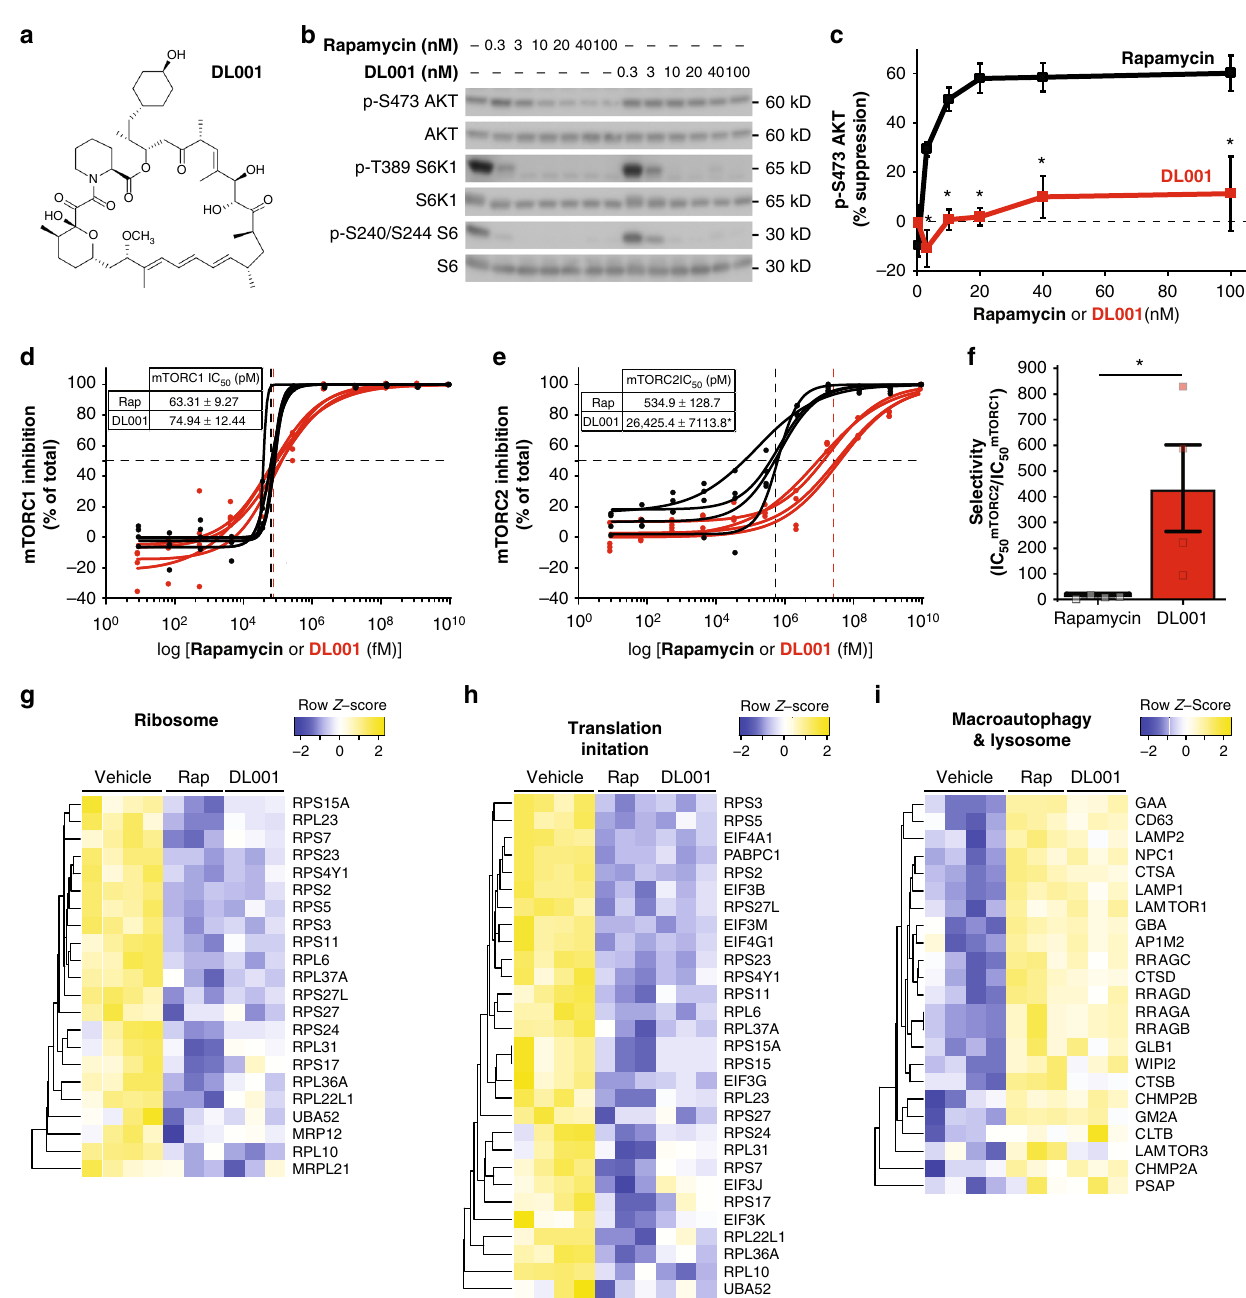
Fig. 1 DL001 is a selective inhibitor of mTORC1. a Structure of DL001. b , c PC3 cells were treated with rapamycin or DL001 at 0.3 – 100 nM for 48 h and b the phosphorylation of S6K1 T389 (a mTORC1 substrate), S6 S240/S244 (a readout for mTORC1 activity), and AKT S473 (a mTORC2 substrate) was determined by western blotting; c the inhibition of AKT S473 phosphorylation was plotted ( n = 3 biologically independent experiments; * p < 0.005, Sidak ’ s test following two-way ANOVA). Rapamycin data are plotted in black, DL001 data plotted in red. d – f The IC 50 for rapamycin (Rap) and DL001